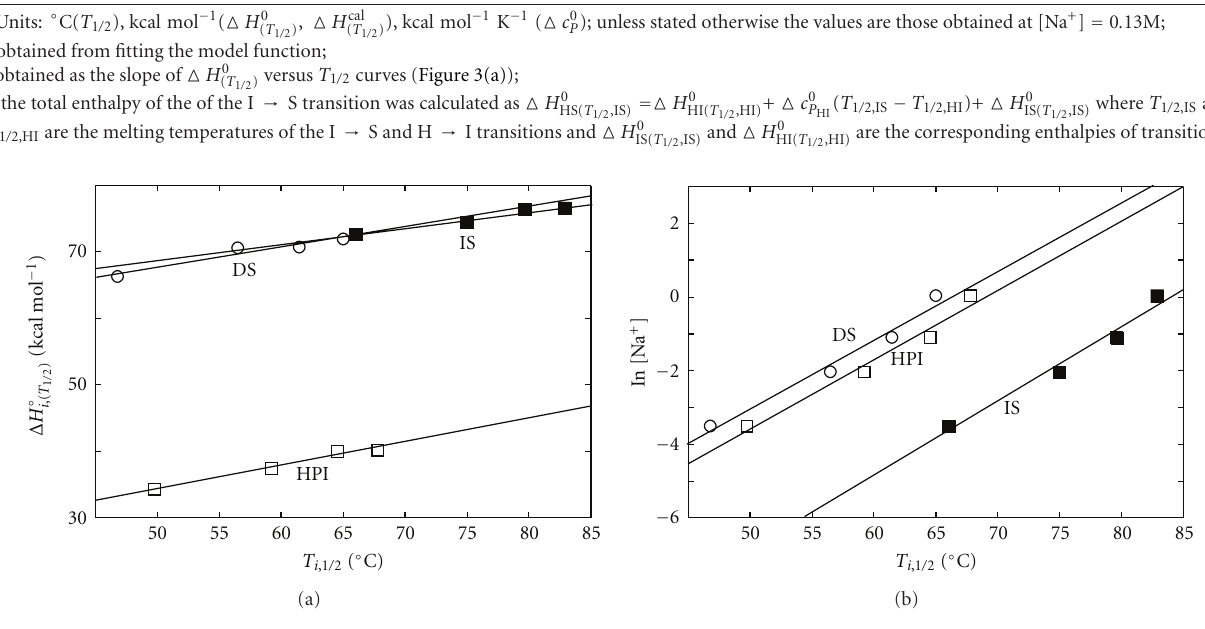
Figure 3: Estimation of heat capacity changes and number of released Na + ions: (a) Δ c 0 P versus T i ,1 / 2 plot constructed from the model based Δ H 0 i the Δ H 0 i ( T i ,1 / 2 ) the corresponding ln[Na + ] versus T i ,1 / 2 plots from which the Δ n Na + , i values were determined according to